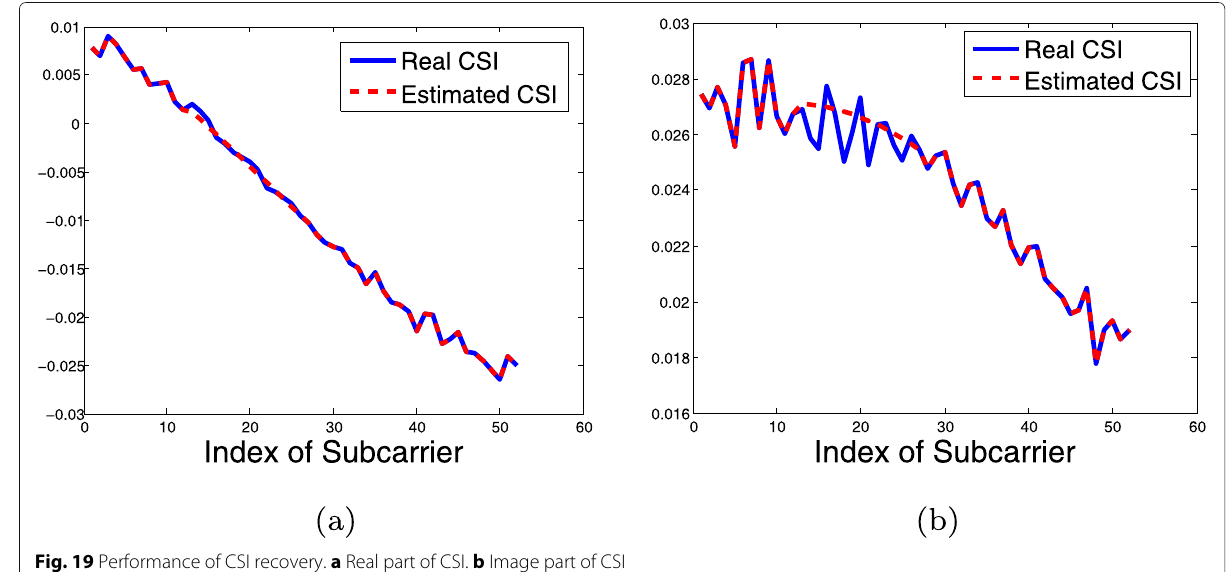
Fig. 19 Performance of CSI recovery. a Real part of CSI. b Image part of CSI